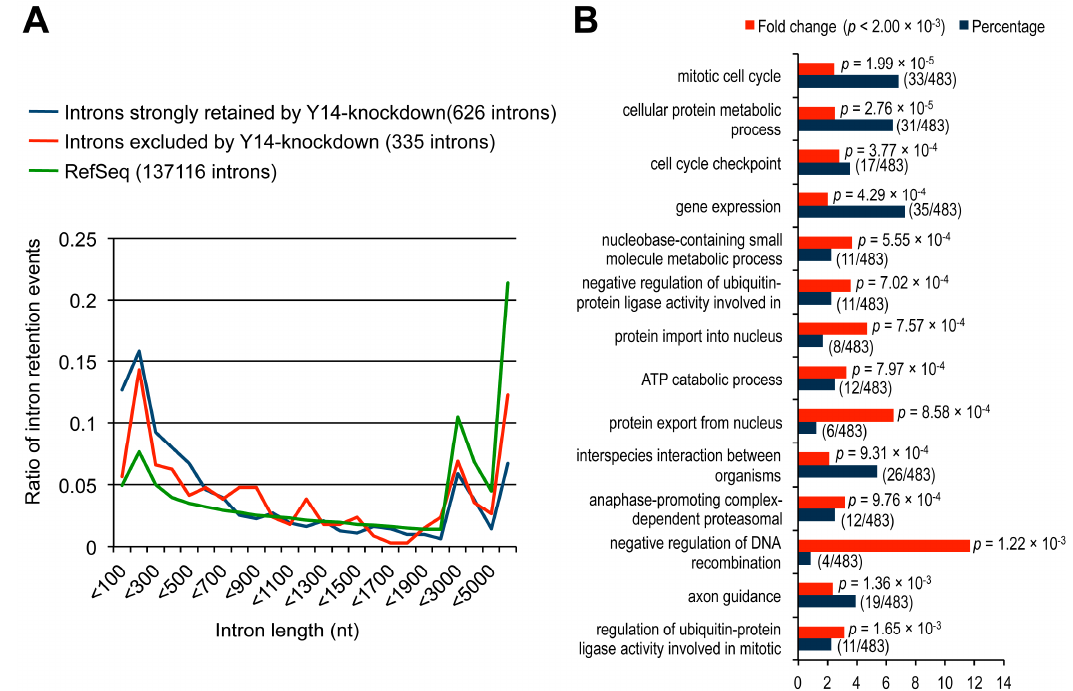
Figure 3. A majority of retained introns in Y14 knockdown cells are short (<500 nt) and exist in a subset of genes involved in cell cycle and apoptosis. ( A ) Retained introns in control siRNA-, Y14 siRNA-treated HeLa cells and RefSeq were grouped by length and plotted as a ratio to the total introns; and ( B ) gene ontology (GO) analysis indicated the functions of 483 genes that showed intron retention inY14 siRNA-treated HeLa cells.